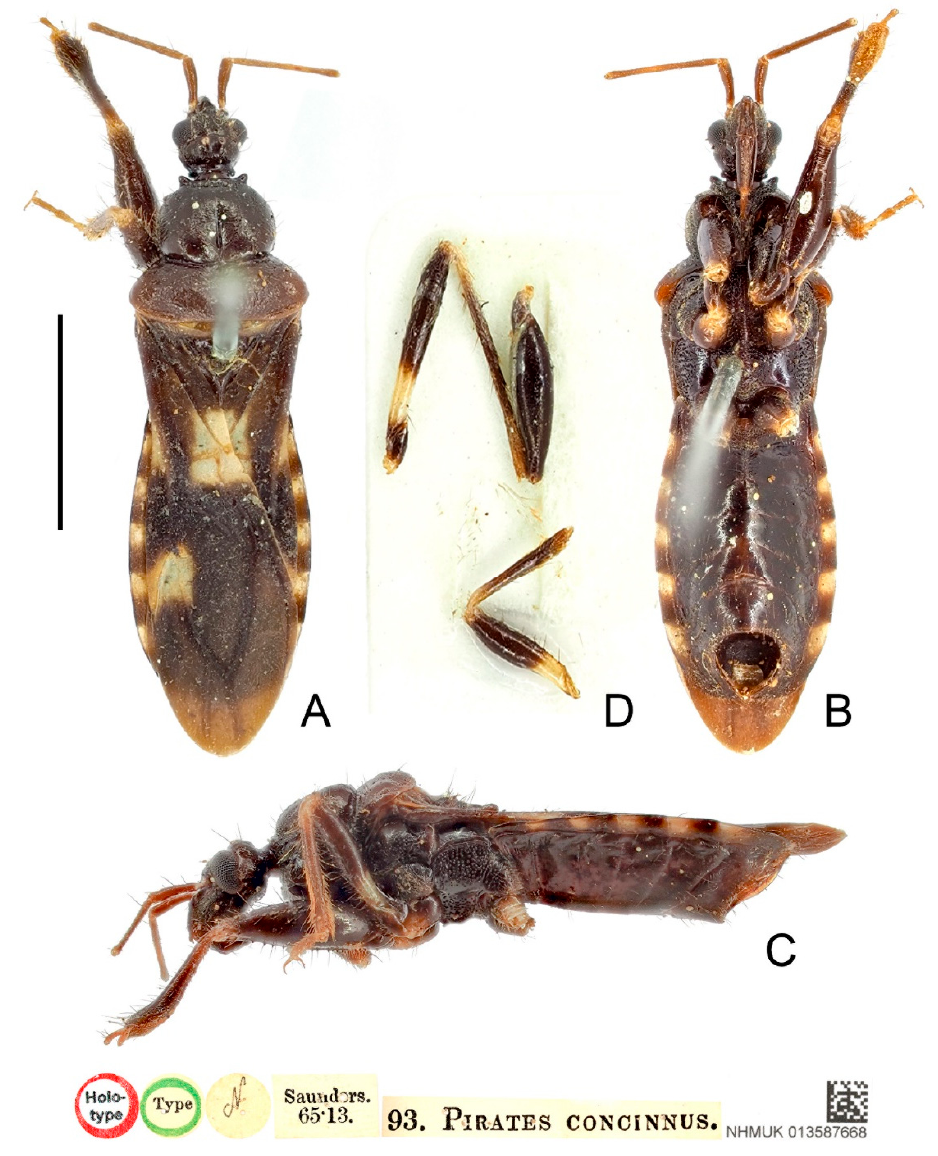
Figure 14. Sigicoris sexguttatus comb. nov. , holotype of Pirates concinnus , male. ( A ) Habitus in dorsal view. ( B ) Habitus in ventral view. ( C ) Habitus in lateral view. ( D ) Legs stuck on the card. Scale bar = 3.00 mm.